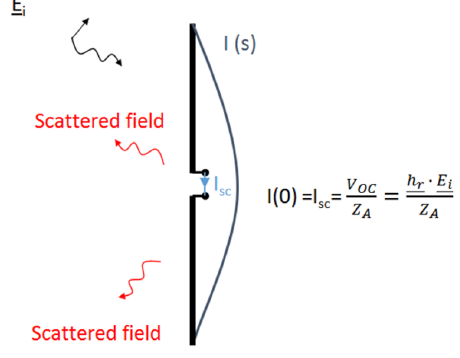
Fig. 1. The receiving antenna scheme